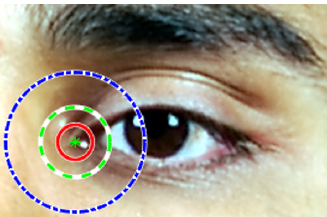
Figure 5. Detection thresholds of the eye inner corner. Concentric circles denote error ranges with radii 0.05 (red solid line), 0.1 (green dashed line), and 0.2 (blue dash-dotted line) times IOD, respectively. Eye image extracted from the IST-EURECOM LFFD.